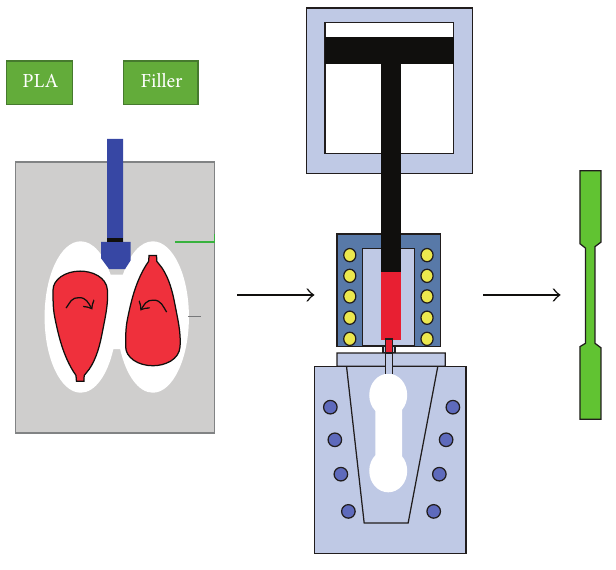
Scheme 1: Scheme for sample preparation.